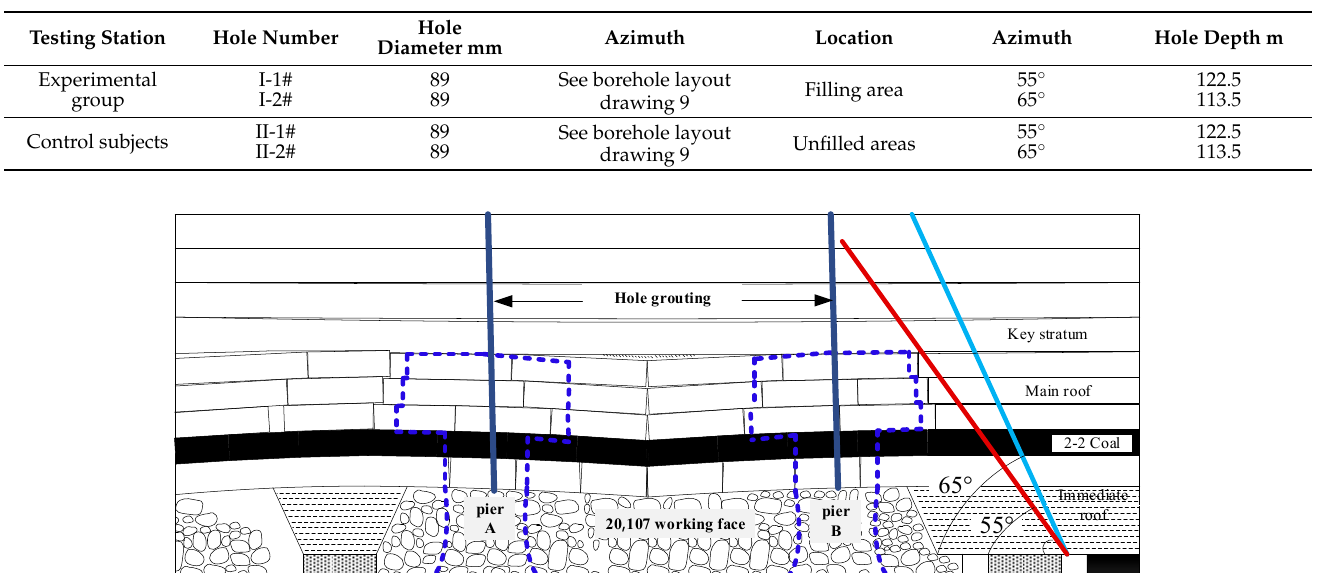
( b ) Figure 8. Schematic diagram of the slurry-making process and the mixing plant: ( a ) Slurry-making process flow diagram; ( b ) Mixing plant. 5. Multi-Arch Pier-Column Infill Support and Results Analysis 5.1. Shallow Stope Overburden Fracture Zone Detection Detecting the development height and influence range of the overburden fracture zone after backfilling can not only reveal the overburden damage and transport of the shallow buried stope, but also reflect the filling effect. For the test group, we chose to set up the detection station in the filled working face, which contained two boreholes, namely